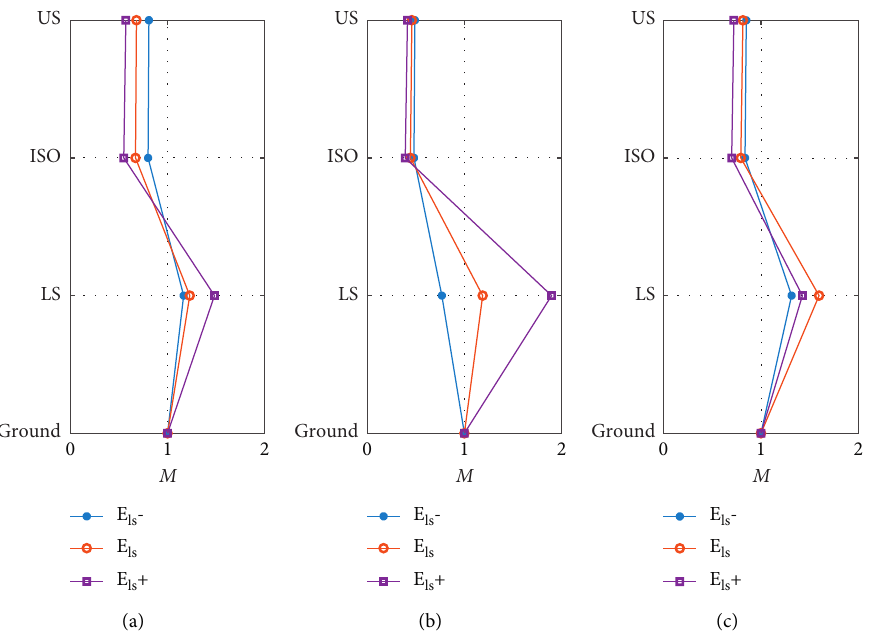
Figure 14: The magnification factor M for Case 1: (a) El Centro-EW, (b) Taft-NS, and (c)